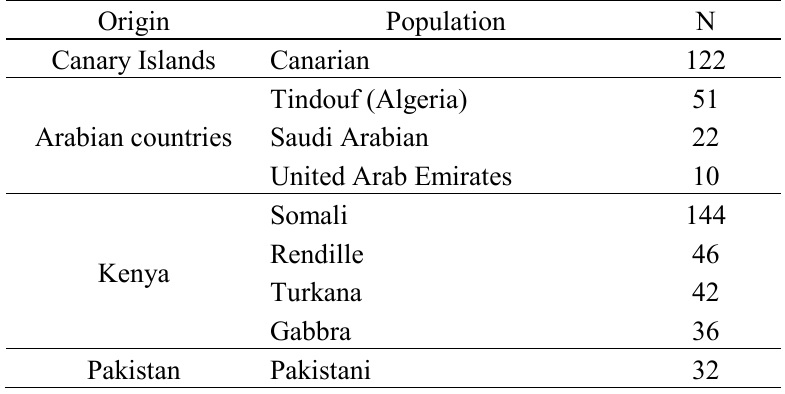
Table 5. Origin and number of the animals included in the